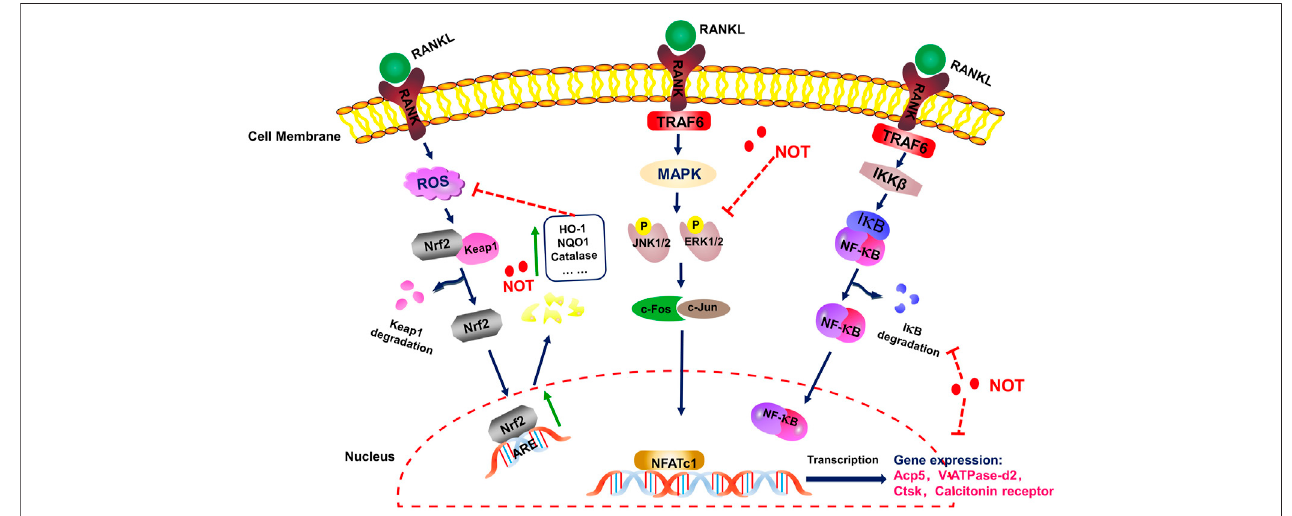
FIGURE 8 | A schematic diagram for illustrating the role of Notopterol in repressing RANKL-mediated osteoclastogenesis through inhibition of NF- κ B, MAPK and calcium signaling pathways as well as promotion of ROS scavenging enzymes.